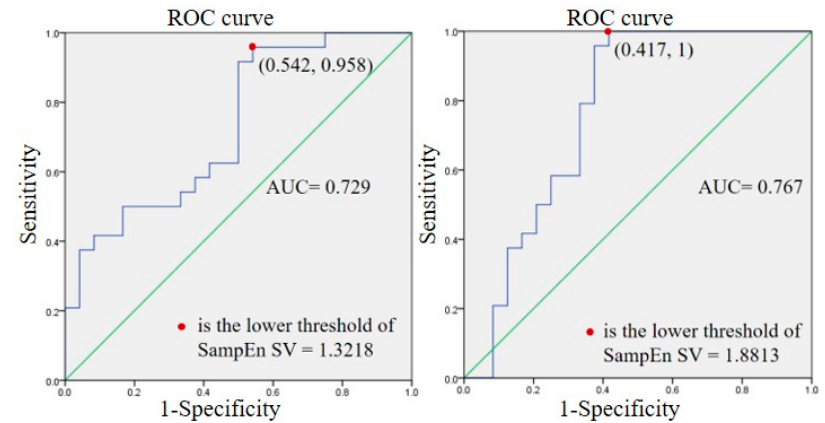
Figure 5. The results for SampEn SV ROC curve.